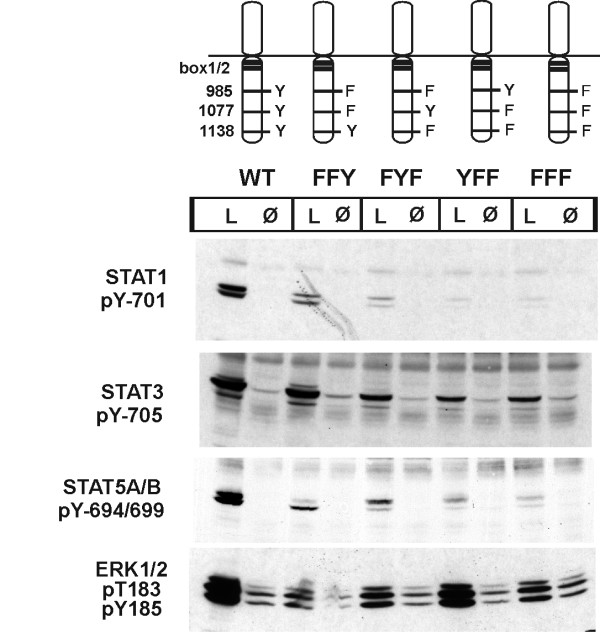
Signalling capacity of RINm5F cells expressing LEPRb point mutants. RINm5F cells stably expressing the wild type LEPRb (YYY) or the indicated LEPRb tyrosine/phenylalanine mutants were treated with 100 ng/ml leptin (L) or vehicle (∅) for 15 min before total cell lysates were prepared. Leptin-induced phosphorylation of downstream signalling molecules was assayed by Western blotting and immunodetection with phospho-specific antibodies.